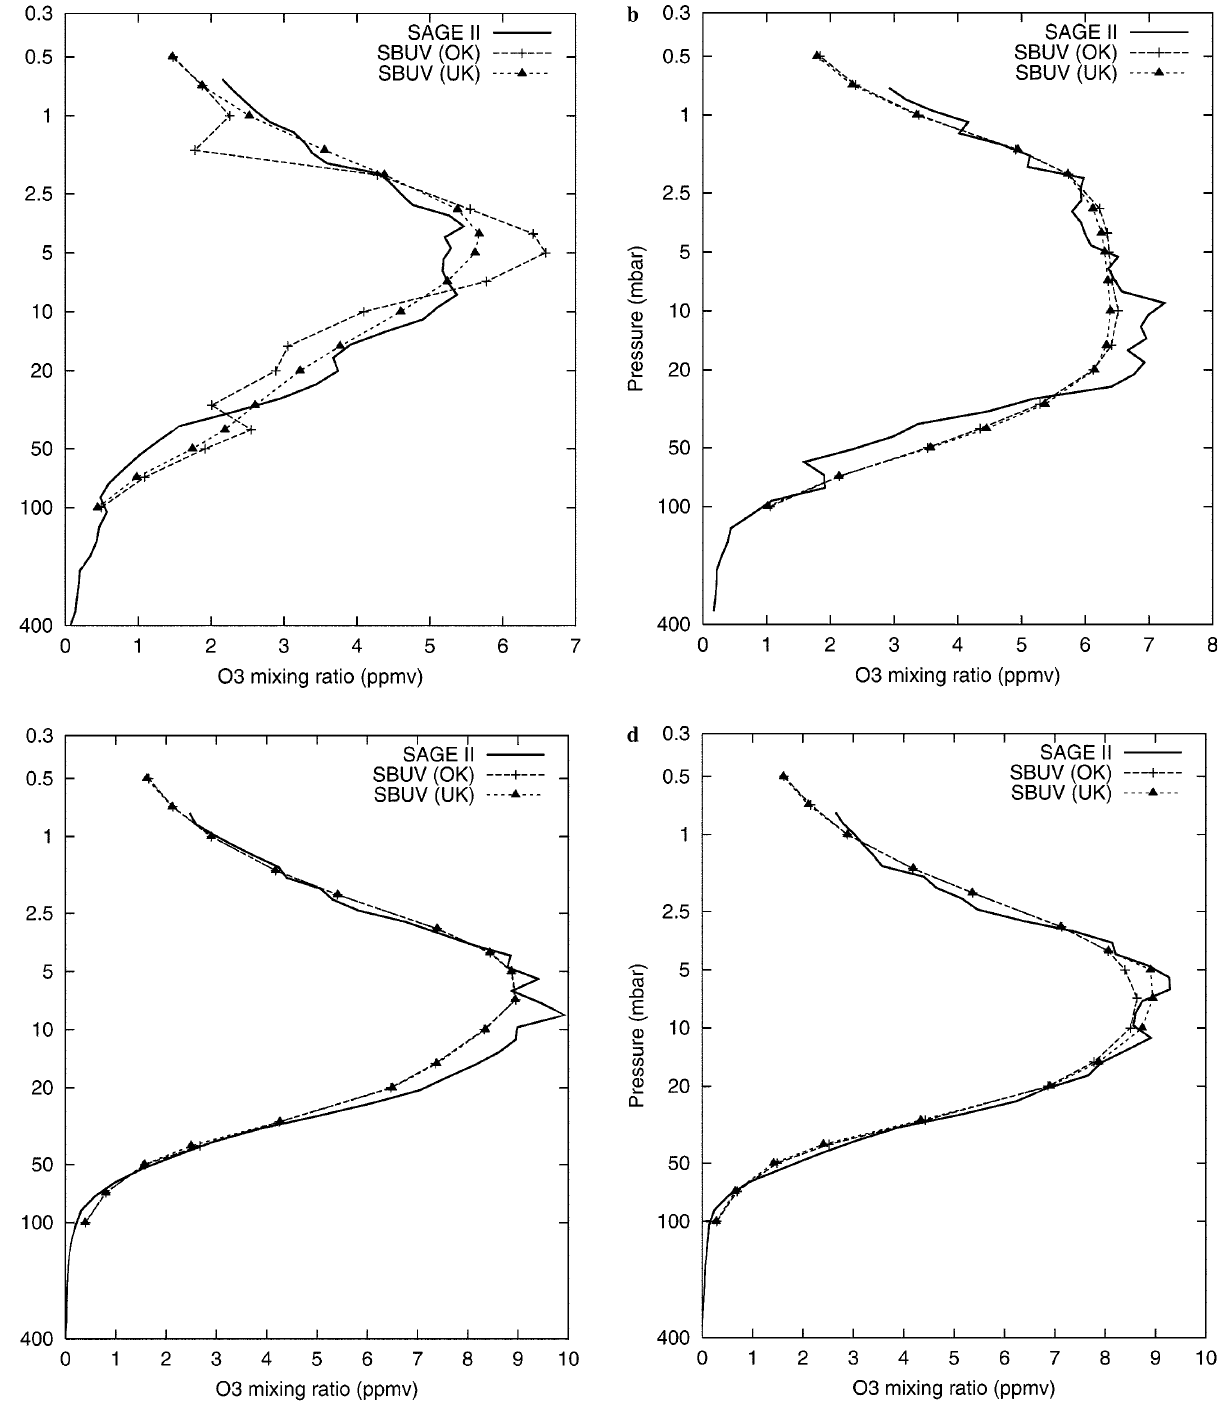
Fig. 6. a Mixing ratio ozone profiles of SAGE II ( line ) in the Southern Hemisphere compared to those obtained with interpolation of SBUV, ordinary kriging (+) and universal kriging (*). The nearest data point of SBUV is at h (cid:136) 0 : 51 (cid:14) . Latitude (cid:136) (cid:255) 71 : 7 (cid:14) , longitude (cid:136) 60 : 8 (cid:14) , October 5, 1988. b Mixing ratio ozone profiles of SAGE II (x) in the Southern Hemisphere compared to those obtained with interpolation of SBUV, ordinary kriging (+) and universal kriging (*). The nearest data point of SBUV is at h (cid:136) 2 : 16 (cid:14) . Latitude (cid:136) (cid:255) 71 : 9 (cid:14) , longitude (cid:136) 156 : 4 (cid:14) , October 5, 1988. c Mixing ratio ozone